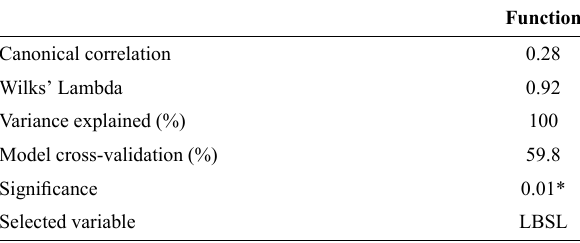
Table 3 - Discriminant analysis for prediction of technical actions in small-sided